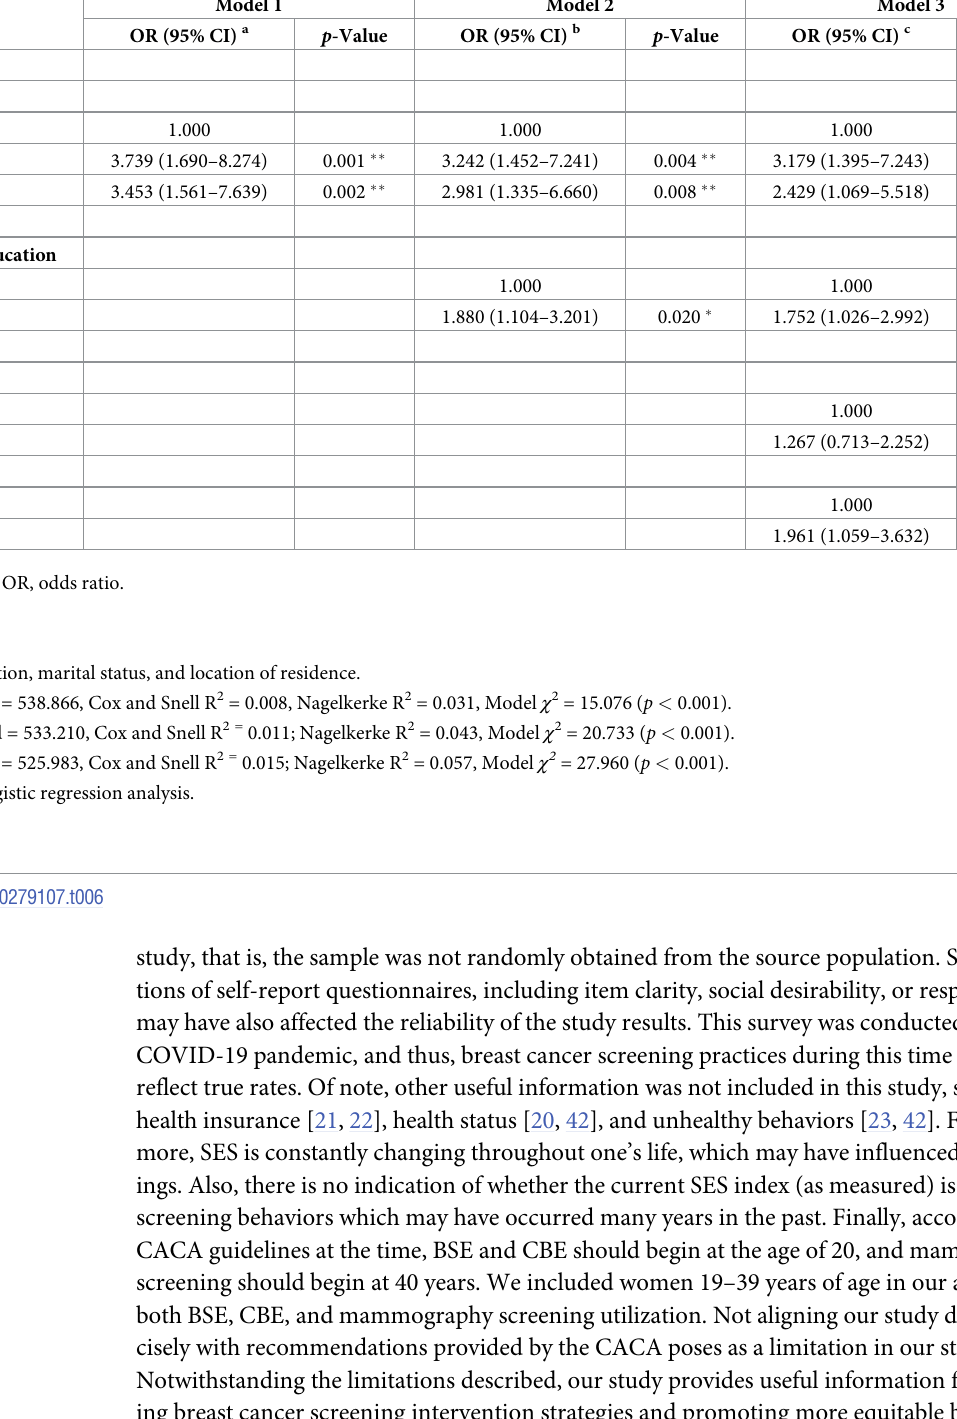
Table 6. Multivariate logistic regressions of mammography practice by SES index (n = 1816).